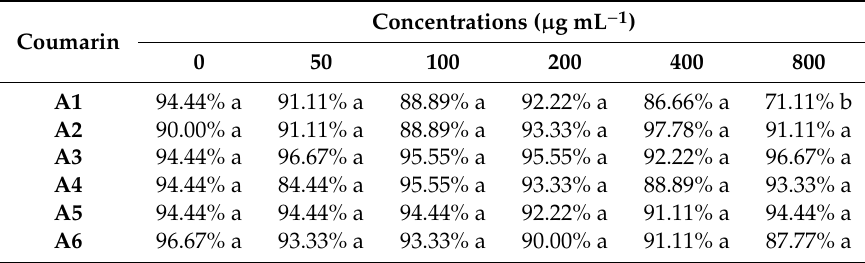
Table 1. Frequency of germinated seeds of Lactuca sativa seedlings exposed to the six eugenol-derived coumarins.